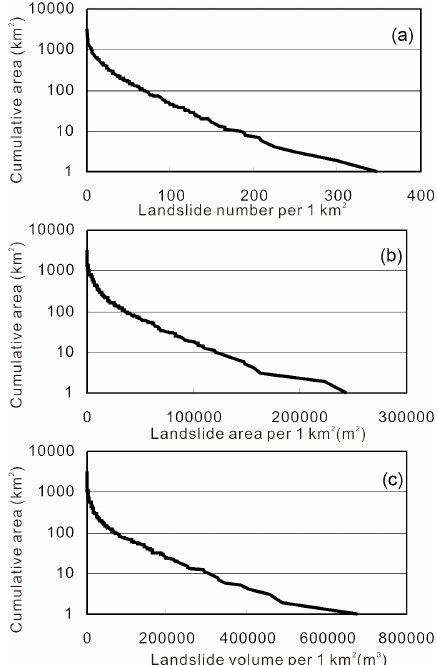
Figure 28. Curves of LND, LAP, and LET with the area distribu- tion. (a) LND (centroid), (b) LAP, and (c)